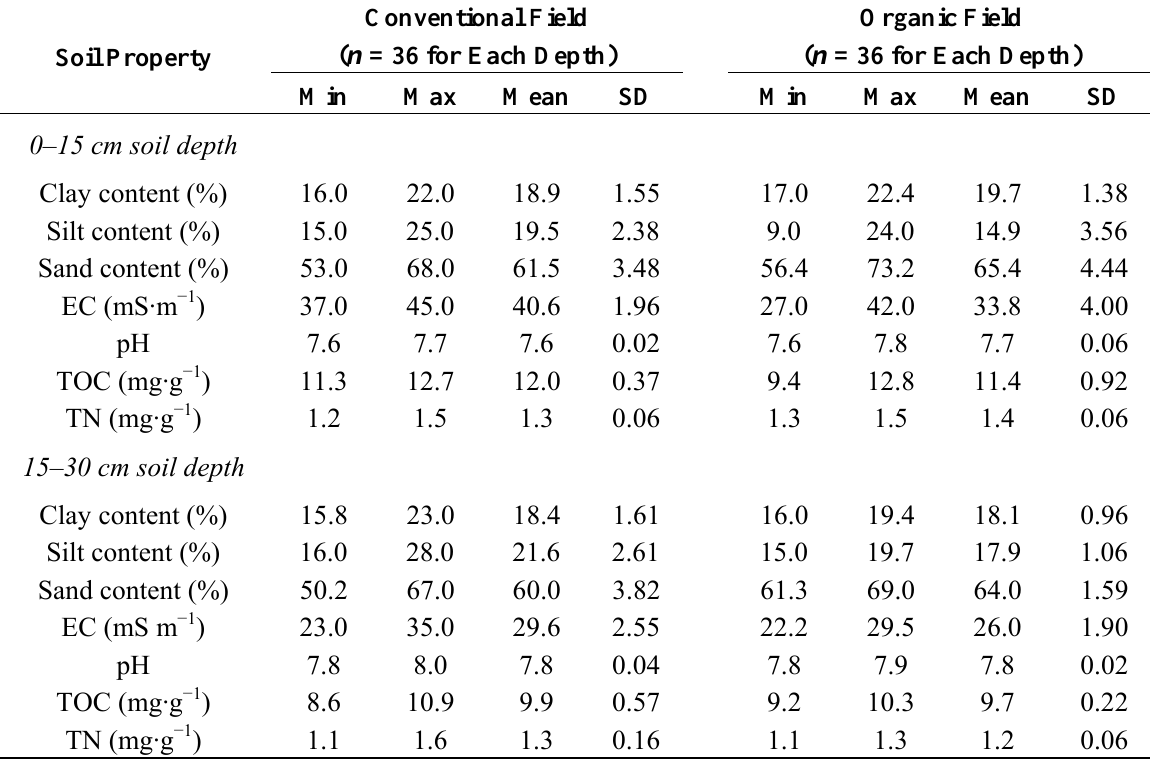
Table 2. Descriptive statistics of soil properties of both fields (All laboratory analyses were done with the highest accuracy according to the appropriate ISO